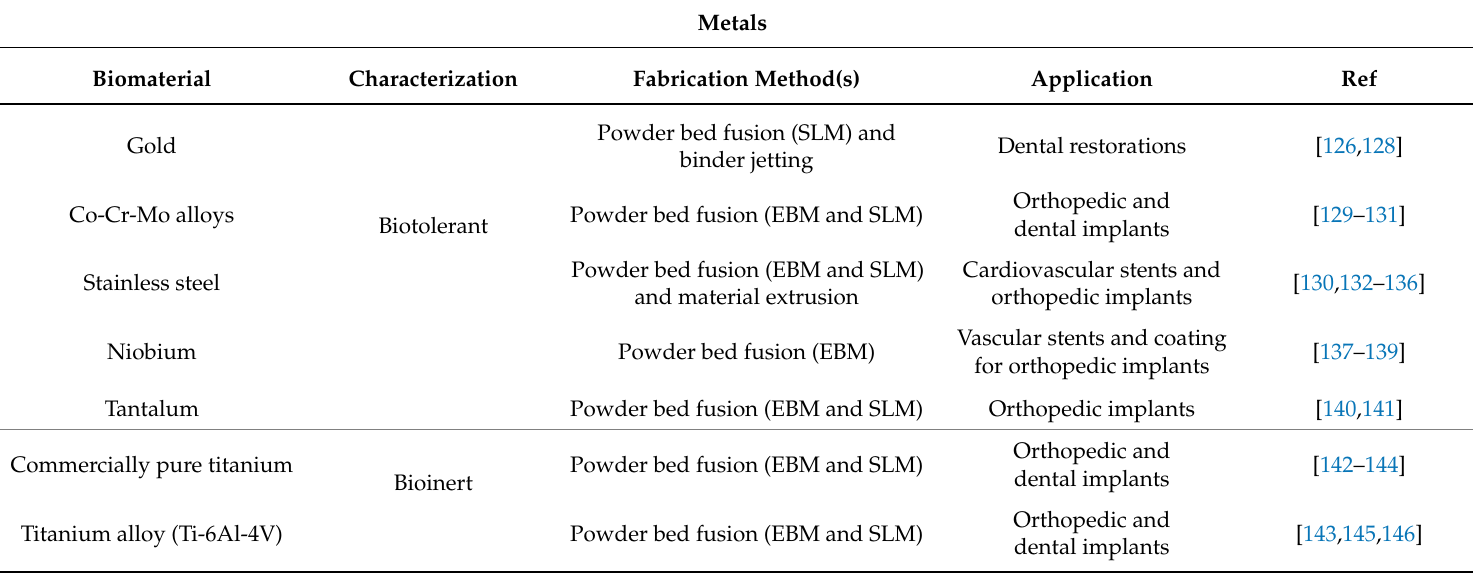
Table 3. Biocompatible metals. The table gives an example of biocompatible metals, their characterization, applications, and additive manufacturing